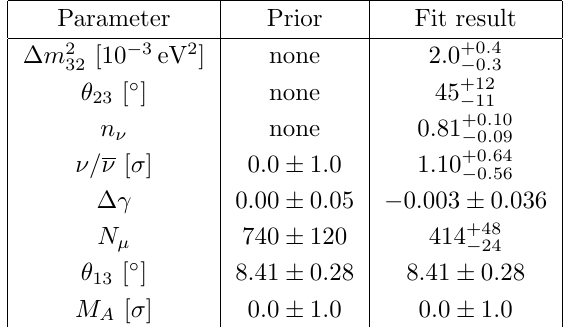
Table 2 . Priors and (cid:12)tted values obtained from the minimisation for all the parameters considered in the standard oscillation